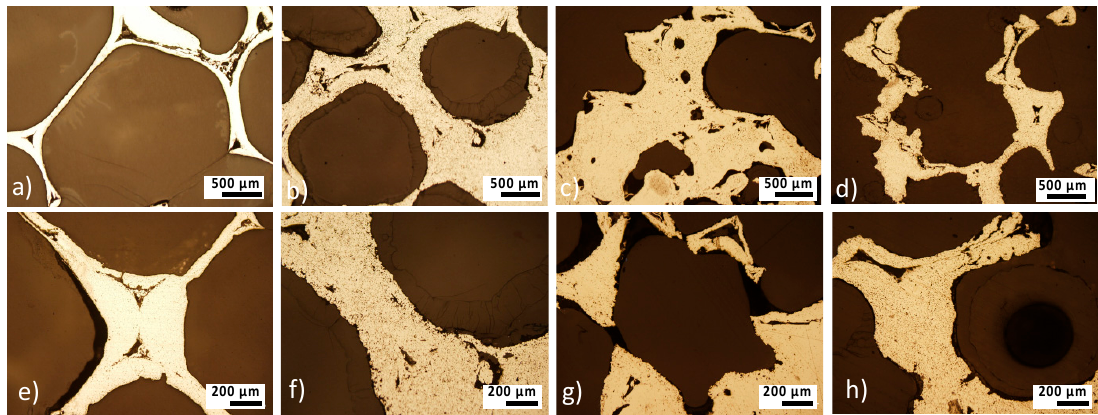
Figure 4. Metallographic cross-sections of the ( a , e ) Fe; ( b , f ) Fe-PEI1; ( c , g ) Fe-PEI2; and ( d , h ) Fe-PEI3 before corrosion.